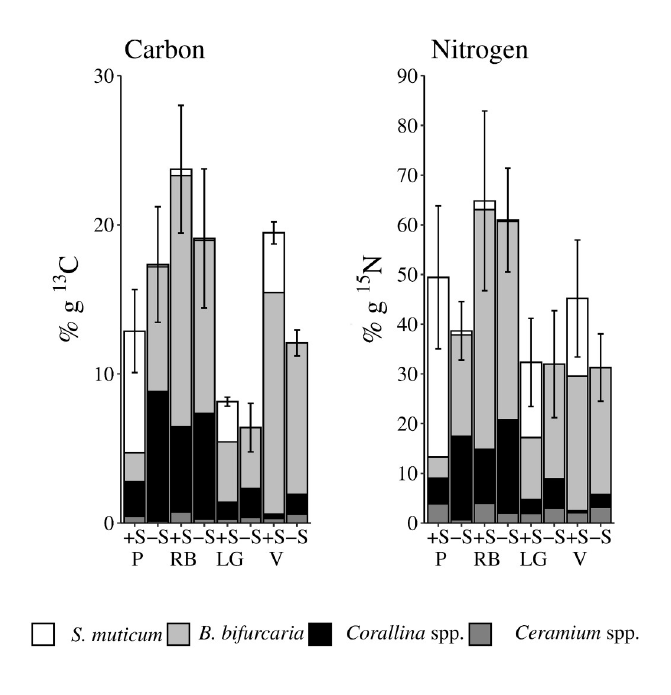
Fig 3. Macroalgal carbon and nitrogen pools. Mean (SE) mg 13 C-carbon and 15 N-nitrogen retained by the assemblage of the 3 native species ( B . bifurcata , Corallina spp and Ceramium spp.) and S . muticum . The average contribution of each species to these pools is indicated in different colors. P, RB, LG, V, as indicated in Fig 1 legend.